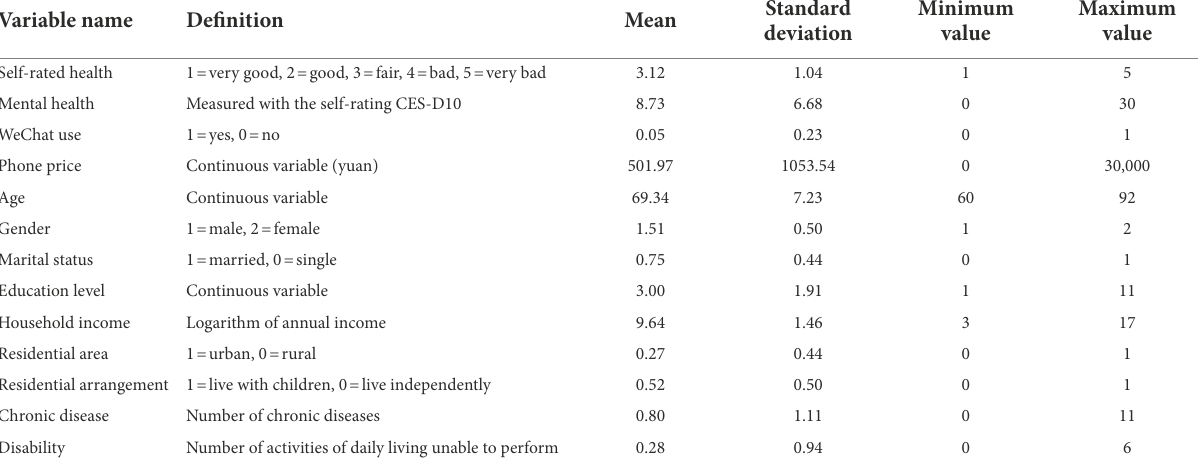
TABLE 1 Variable definitions and descriptive statistics (China Health and Retirement Longitudinal Study, China, 2018). Variable